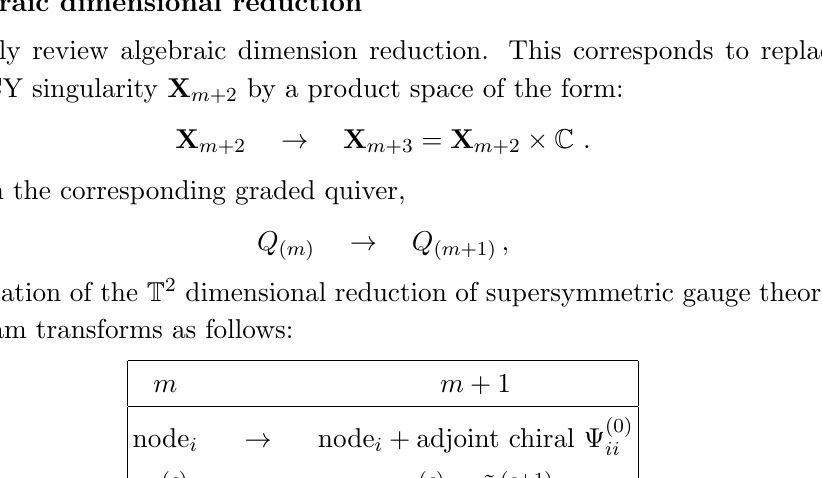
Figure 2 . Toric diagrams for F ( m )